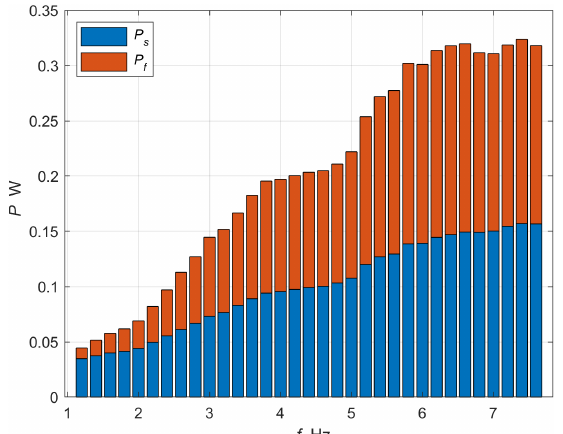
Figure 3. Electric power delivered to the servomotor: P s —power for servomotor without a fin, and P f —power for a fin submerged in the